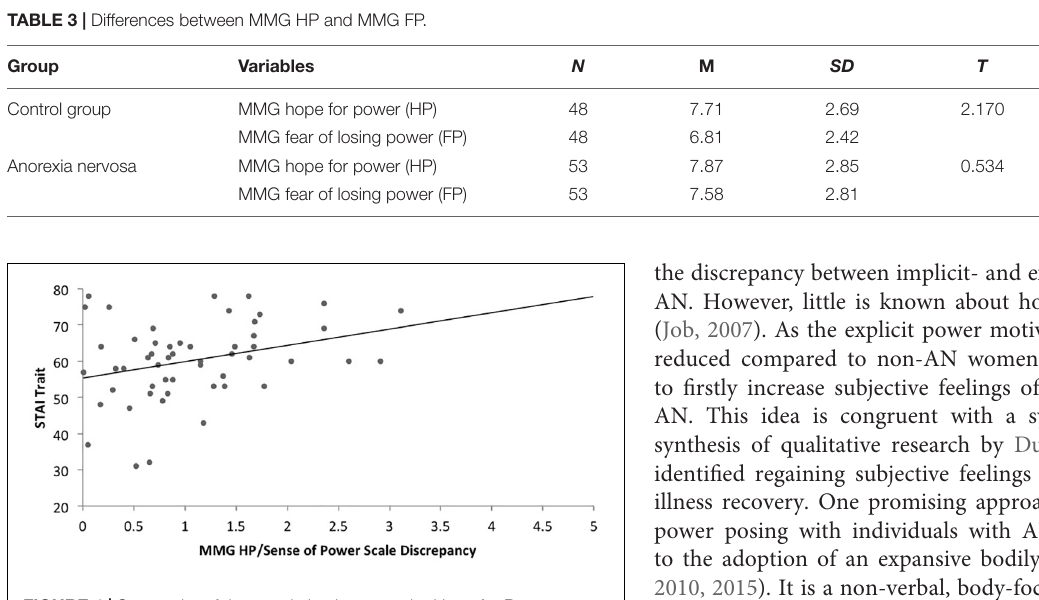
FIGURE 4 | Scatterplot of the correlation between the Hope for Power (MMG)/Personal Sense of Power Scale discrepancy and trait anxiety in women with AN.